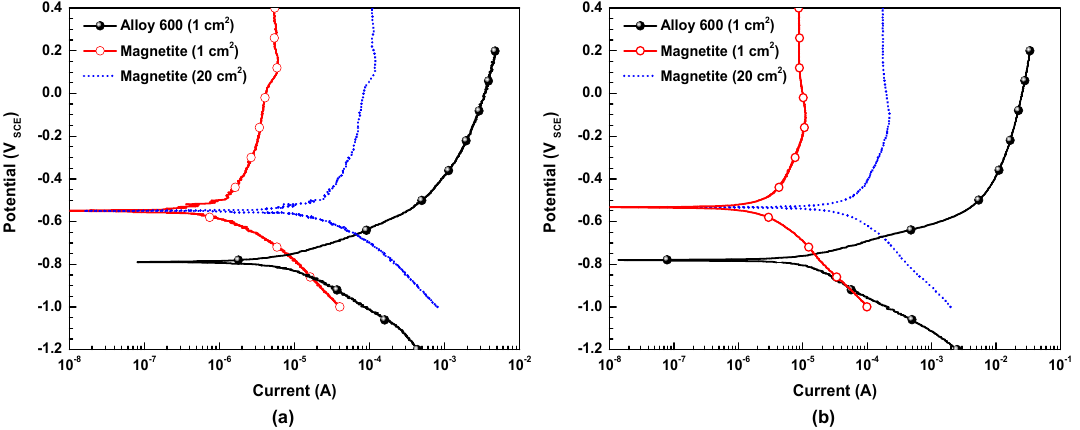
Figure 7. Potentiodynamic polarization curves of carbon steel and magnetite in test solutions at 80 °C : ( a ) Reference solution and ( b ) reference solution with 0.05 M sulfate ions.